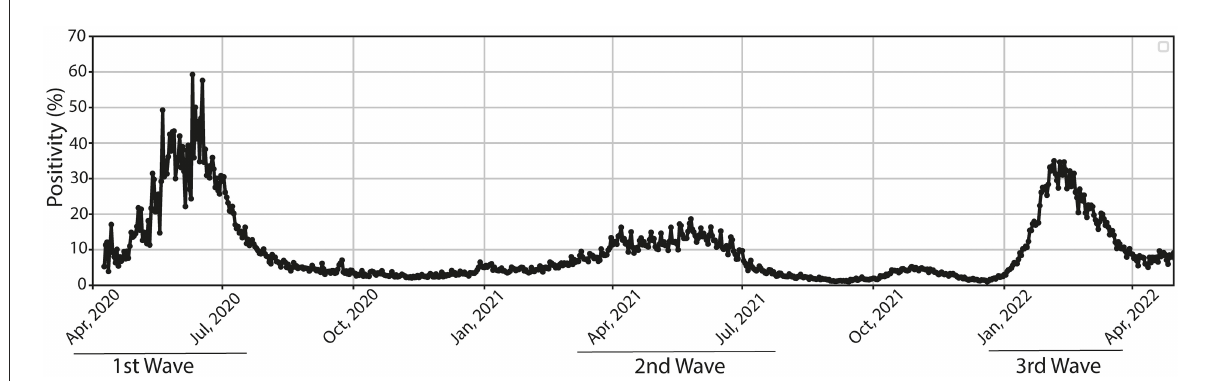
FIGURE2 Positivity of COVID-19 in the Metropolitan Region of Santiago. The positivity (%) in the Metropolitan region is shown from April 2020 to April 2022. The first wave is indicated between the months of April and July 2020, the second wave corresponds between March 2021 and the end of July of the same year, while the third wave of infections begins between the months of January 2022 and April 2022.